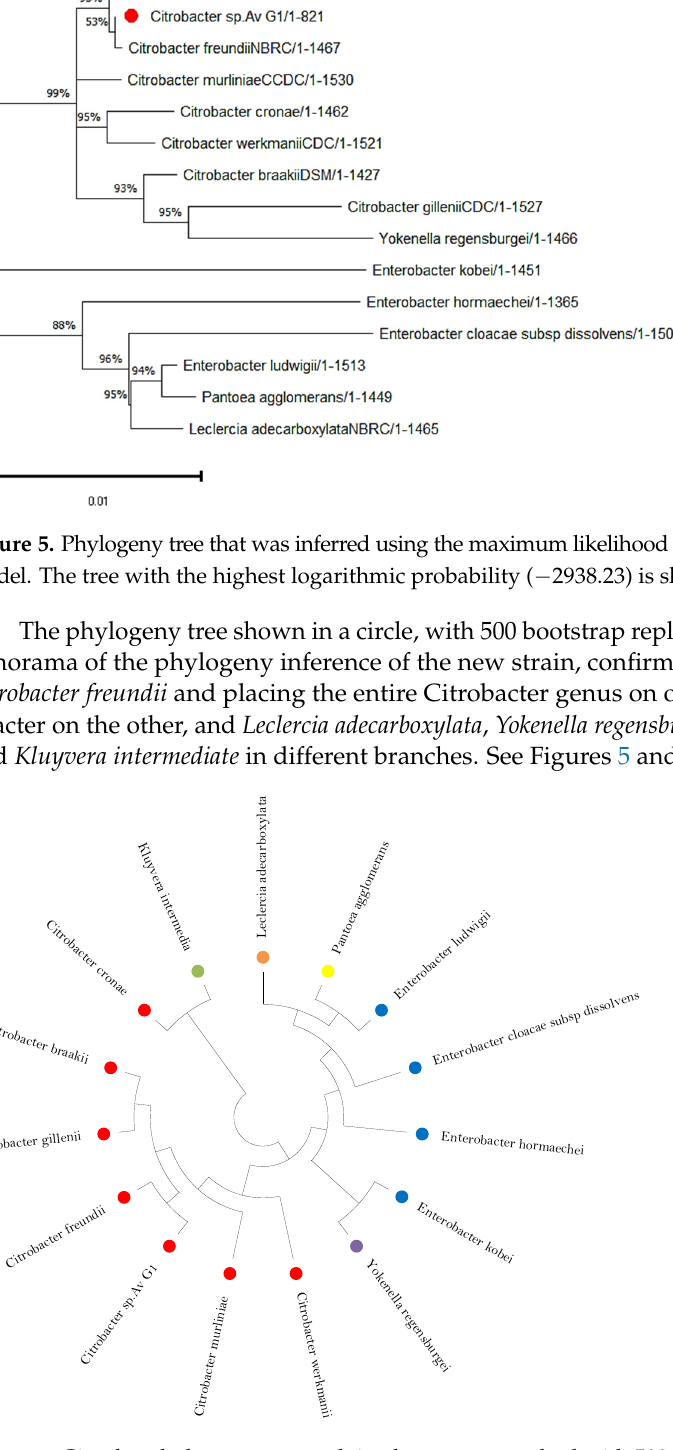
8 of 14 Figure 4. Morphological characterization of the Av_G1 strain: ( A ) isolation of bacteria by LB agar after 24 h, ( B ) observation of the final replicate of the Av_G1 strain under an optical microscope and Gram-negative staining. ( C ) Citrobacter sp. Av_G1 from the biofilm under electron microscopy with